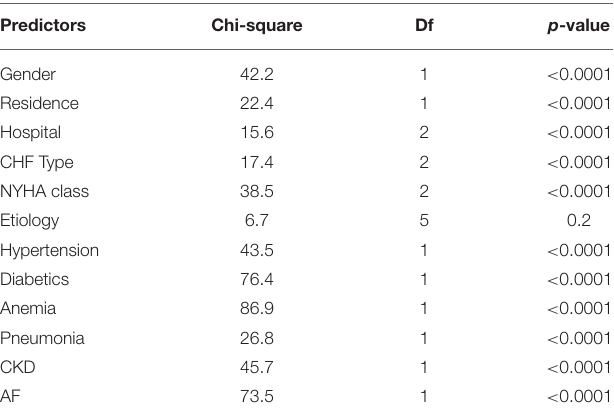
TABLE 3 | Log-rank test for categorical independent variables.